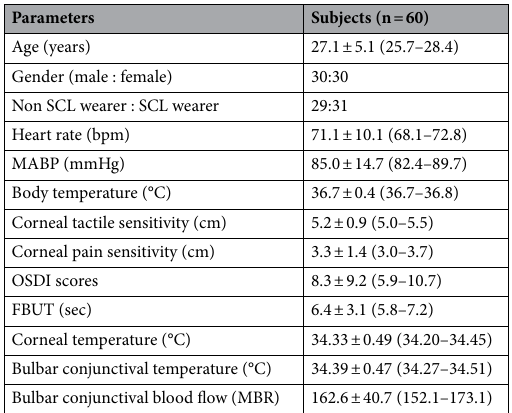
6.4 ± 3.1, 4.4 ± 2.4 and 5.8 ± 3.2 s, respectively. Although the FBUT value for the mask group was significantly shorter than that found for the no mask and taped mask groups ( P < 0.01 and P < 0.05, respectively, Tukey HSD Corneal and bulbar conjunctival temperature. The difference in the corneal temperature (Δcorneal temperature) between the no mask and mask groups (0.19 ± 0.28 °C, mask minus no mask) was significantly higher than the difference observed between the no mask and taped mask groups (0.05 ± 0.27 °C, taped mask minus no mask) ( P < 0.01, paired t-test, Fig. 2A). The difference in the bulbar conjunctival temperature (Δconjunctival temperature) between the no mask and mask groups (0.13 ± 0.28 °C) was significantly higher than that found between the no mask and taped mask groups (0.06 ± 0.24 °C) ( P < 0.05, Fig. 2B). Representa- tive images of the conjunctival and corneal temperature with no mask, mask, and taped mask were shown in Fig. 3A–F. Conjunctival blood flow. The change in the bulbar conjunctival blood flow between the no mask and the mask conditions (1.14 ± 0.20) was significantly higher than that observed between the no mask and the taped mask conditions (1.03 ± 0.12, P < 0.01, Fig. 4). Representative images of the conjunctival blood flow with no mask, mask and taped mask were shown in Fig. 3G–I.